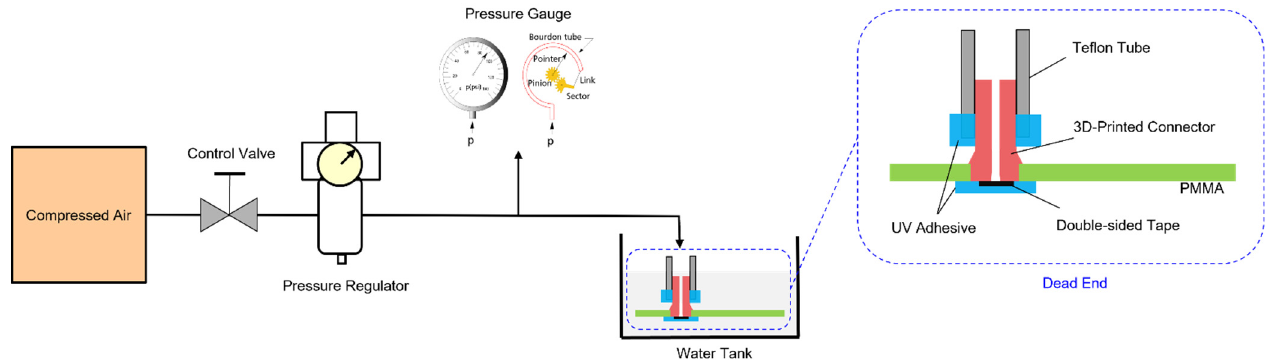
Figure 2. Schematic of pressure test for the 3D-printed connector on PMMA